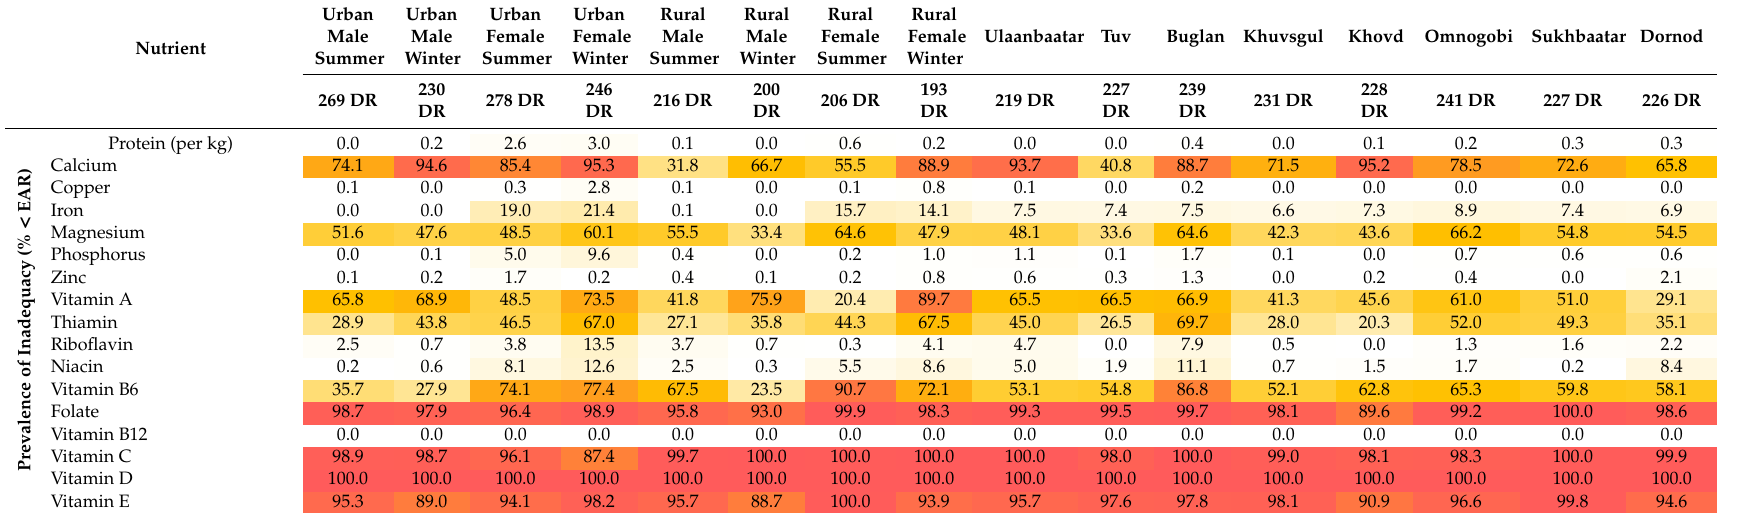
The total number of diet records (DR) available for analysis are listed below each column heading. Within subgroup-seasons and provinces, usual intakes of all nutrients (except alcohol) and nutrient adequacy prevalence are estimated using habitual intake models analyzing up to 3 or 6 record days per person, respectively, while nutrient proportions and ratios are calculated using the sequential averaging procedures described in the footnote to Table 1. Depending on data availability, usual alcohol intake is estimated either using episodic intake models or calculated by sequential averaging. Estimated average requirements are drawn from the Dietary Reference Intakes of the National Academy of Medicine [33]. Intake models are estimated using SPADE [31]. Statistics are weighted by weekday of each record day. Shading is proportional to nutrient inadequacy prevalence (white: 0.0%, red: